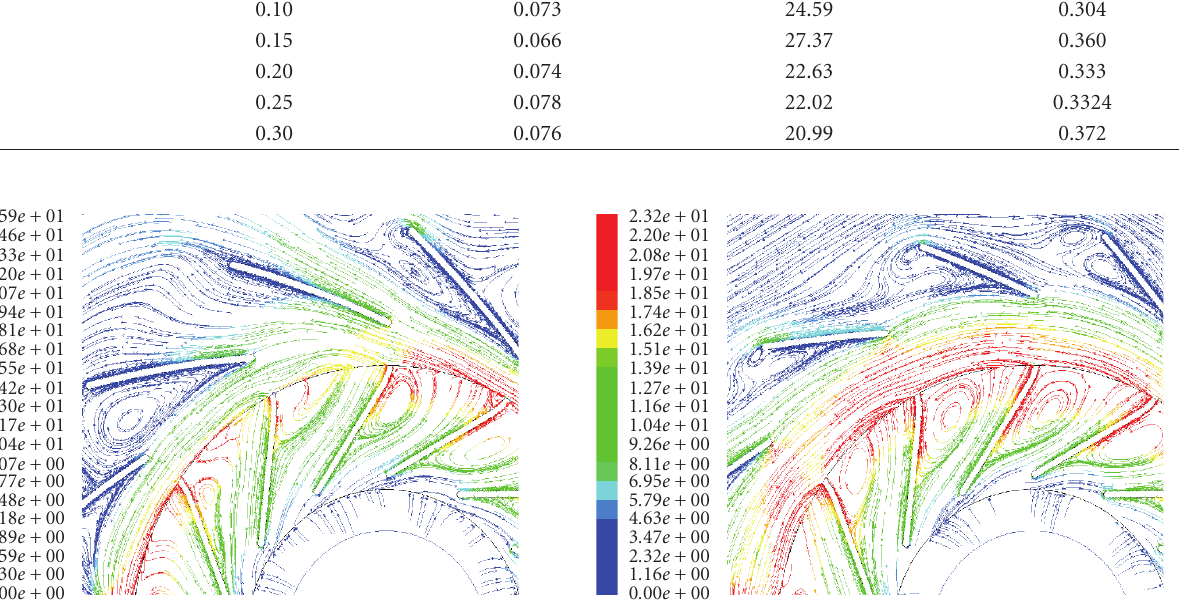
Figure 8: Relative velocity plot for configuration C (radial gap ratio = 0.15).